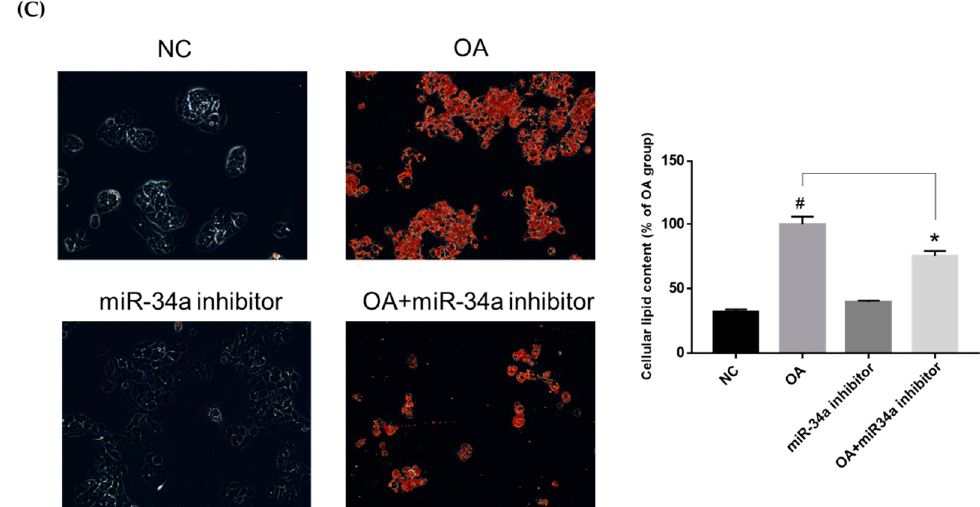
Figure 7. The effect of 5-CQA on miR-34a expression and the effect of miR-34a on lipid accumulation. ( A ) The cells were co-treated with OA and 5-CQA for 24 h. The level of miR-34a was analyzed as described in the text. Treatment with 5-CQA decreased the expression of miR-34a. The results are presented as mean ± SD from three independent experiments for each group. # p < 0.05, in relation to the control group. * p < 0.05, in relation to the OA-induced group. Ctrl, control; OA, oleic acid. ( B ) After transfection with miR-34a mimic or inhibitor, the total cell lysate (protein) was analyzed using immunoblotting against SIRT1, phosphor-AMPK, AMPK, and actin antibody. The data are presented as mean ± SD. # p < 0.05, in relation to the negative control group. ( C ) After miR-34a inhibitor transfection, cells were treated with or without OA for 24 h. The intracellular lipid was stained with Oil Red O and the representative photo was taken. The quantification was determined using colorimetric assay as described in the text. The data are presented as the mean ± SD of three samples of each group. # p < 0.05, in relation to the negative control group. * p < 0.05, in relation to the OA-treated